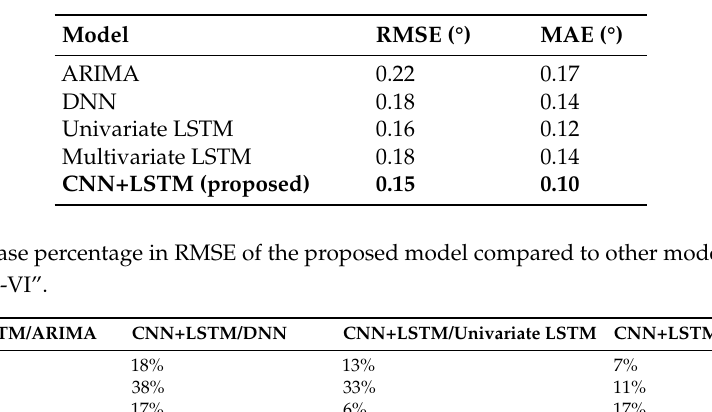
Table 4. RMSEs and MAEs of each model at “JingHai-VI” test set-3.